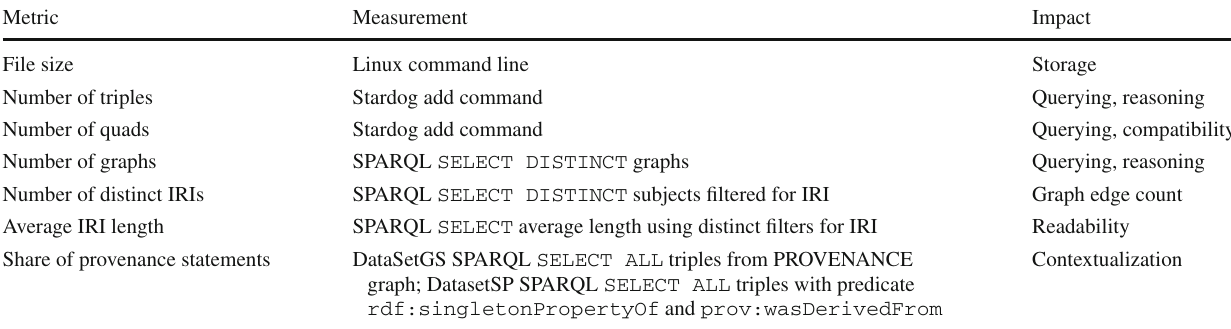
Table 9 Types of metrics considered for quantitative comparison, with their corresponding measurement and